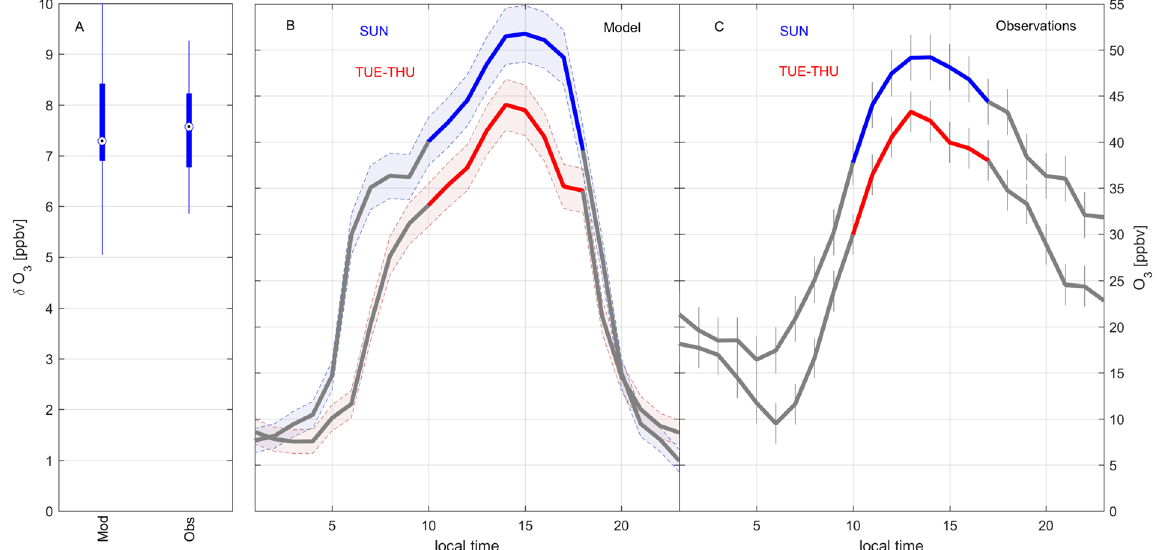
Figure 4. Observed and modelled changes in ozone concentrations on weekdays (Tuesday – Thursday) and weekends (Sunday). Panel A depicts a statistical boxplot showing weekend-weekday differences during daytime, which are represented by the colored sections in panels B and